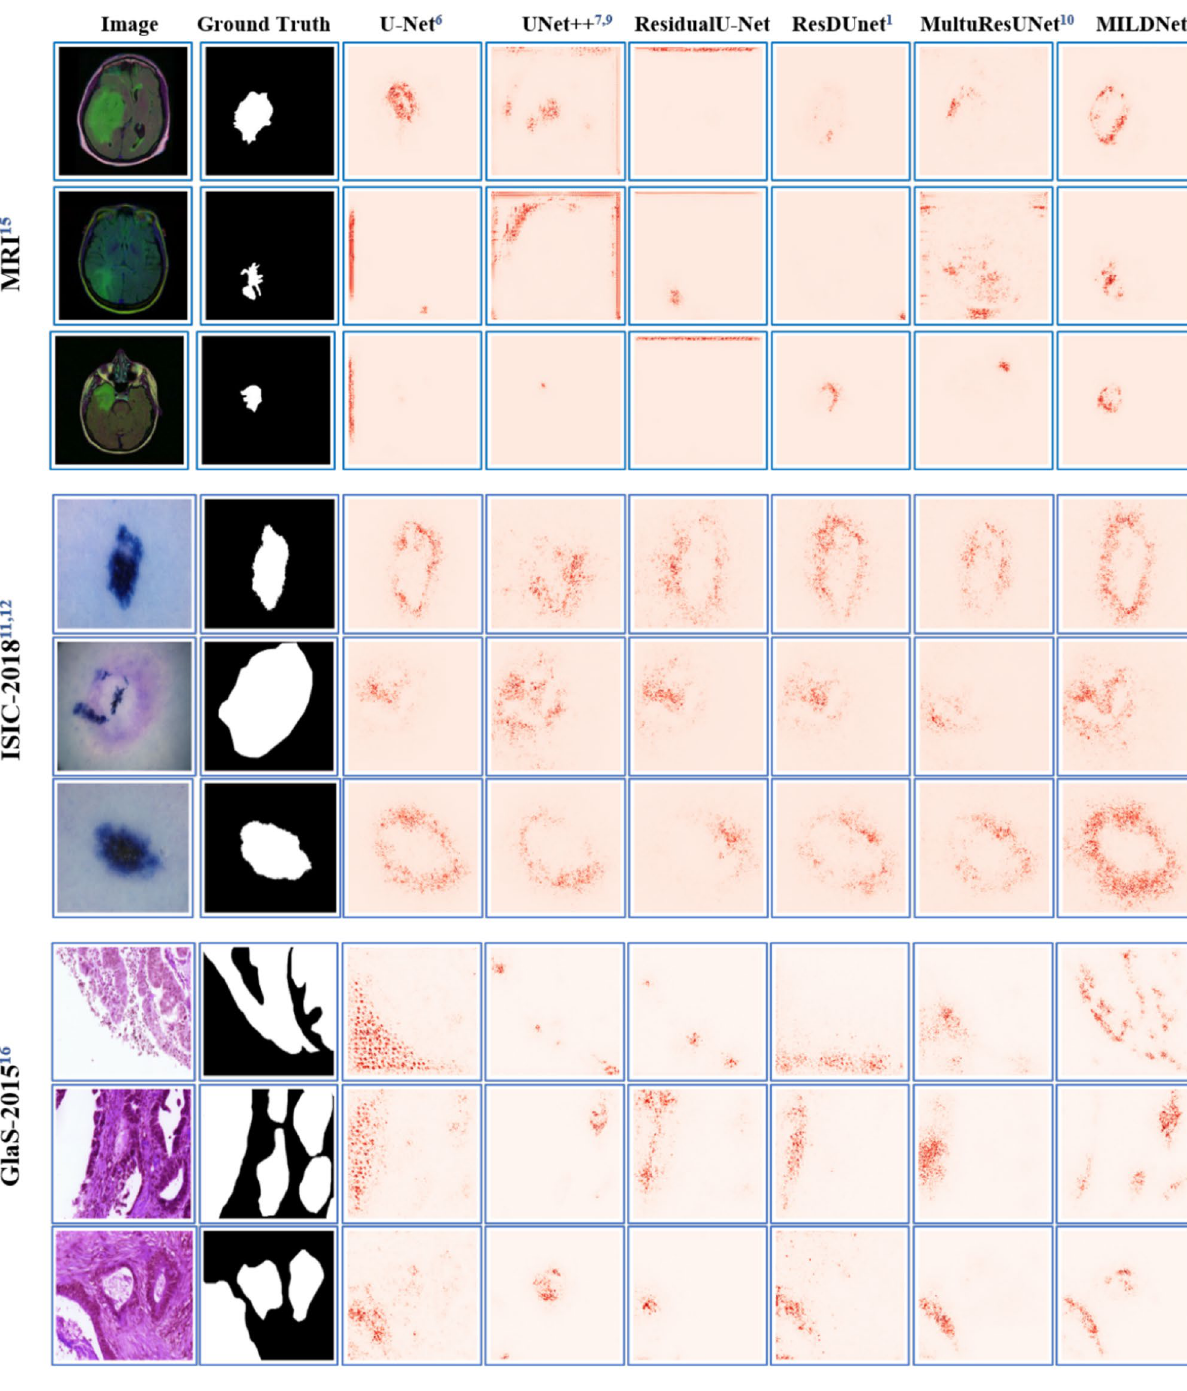
Figure 12 further illustrates an extreme case from the MRI dataset (12a) with its ground truth mask (12b), in which the ROI (tumor region) is very difficult to be identified even by a human expert. In this example, all the models (Figs. 12c,d,e) have struggled to properly segment the ROI, resulting in over-segmentation. MILDNet is robust against outliers. Segmenting the biomedical images often suffers from outliers, which look very similar to the ROI, but they are not a part of it. Segmentation models often fail to distinguish outliers from the ROIs. Figure 13a illustrates an example from the MRI dataset, in which the non-tumor region contains small light green areas (outliers), which resemble the tumor region (ROI) (Fig. 13b). Similarly, Fig. 13f